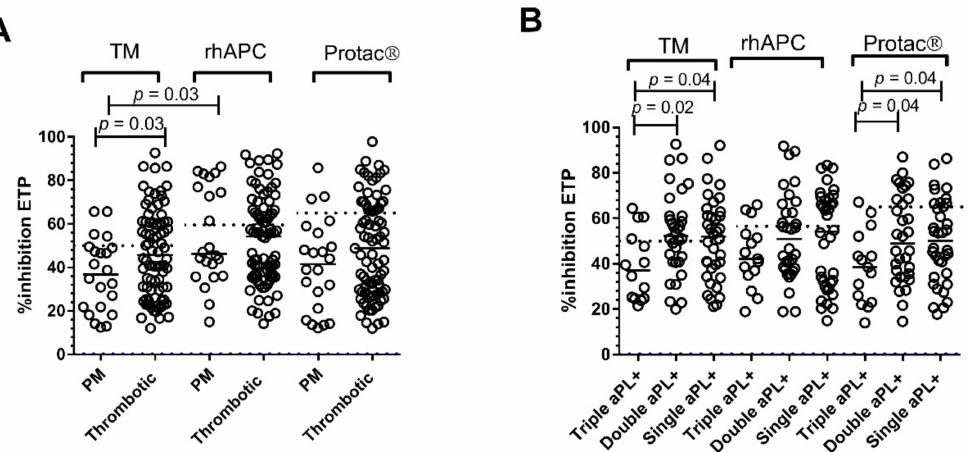
Figure 3. APCr with TM, rhAPC, and Protac ® in APS patients stratified according to ( A ). clinical phenotype: thrombotic and pregnancy complications (PM) and ( B ). antiphospholipid antibody status. Dotted lines indicate the cut off for each method used. Table 2. APCr prevalence and categorical agreement between ST-Genesia ® and the CAT analyser in APS and SLE patients stratified according to antiphospholipid antibody status and thrombotic status. APCr Prevalence n (%) (Median, 95% Confidence